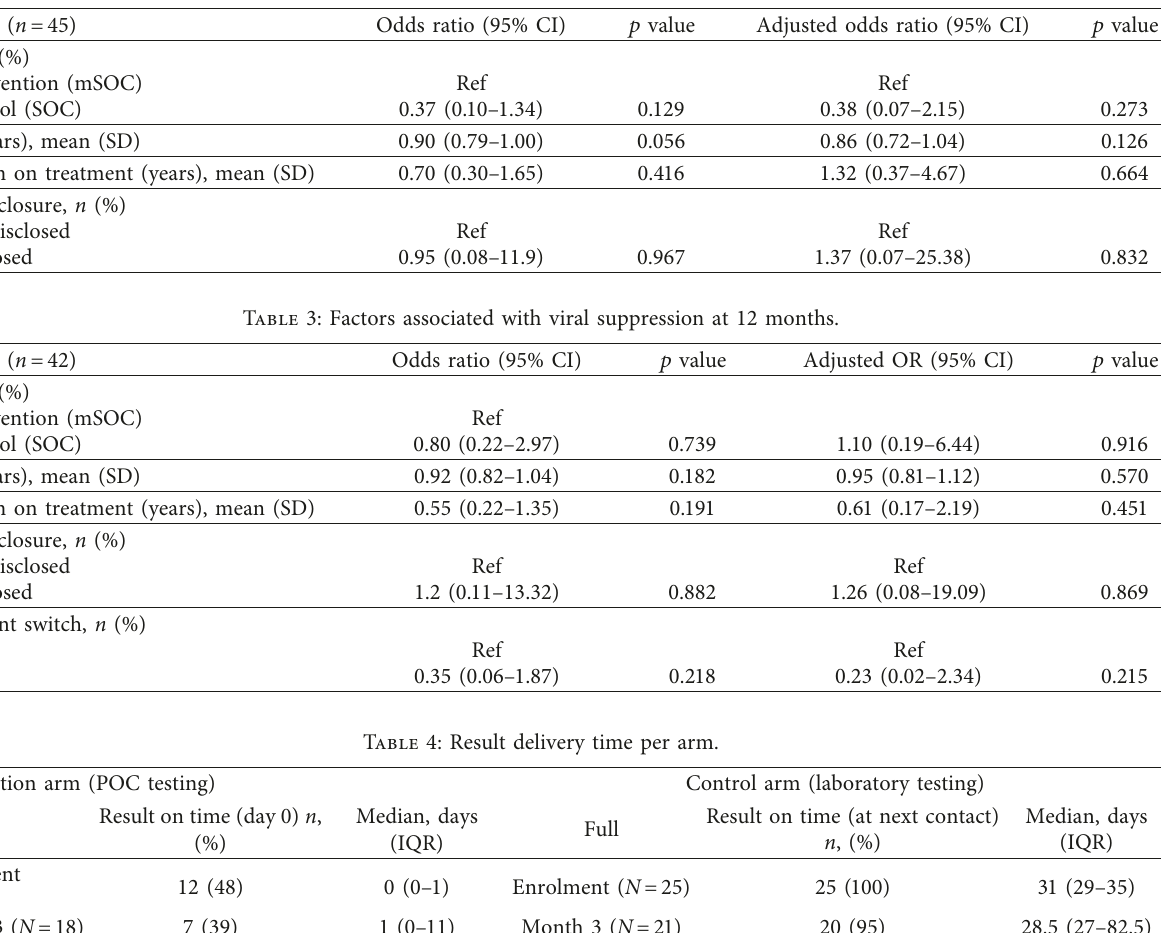
Table 2: Factors associated with viral suppression at 6 months.